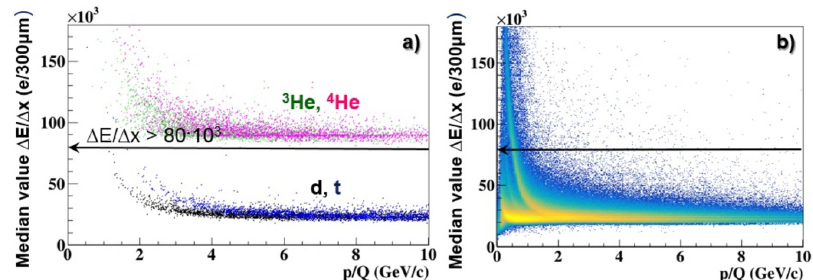
Figure 2. [Color online] The dependences of the median value ∆ E / ∆ x from the particle momentum for a) signal ( 3 He, 4 He), thermal deuterons and tritons and b) UrQMD